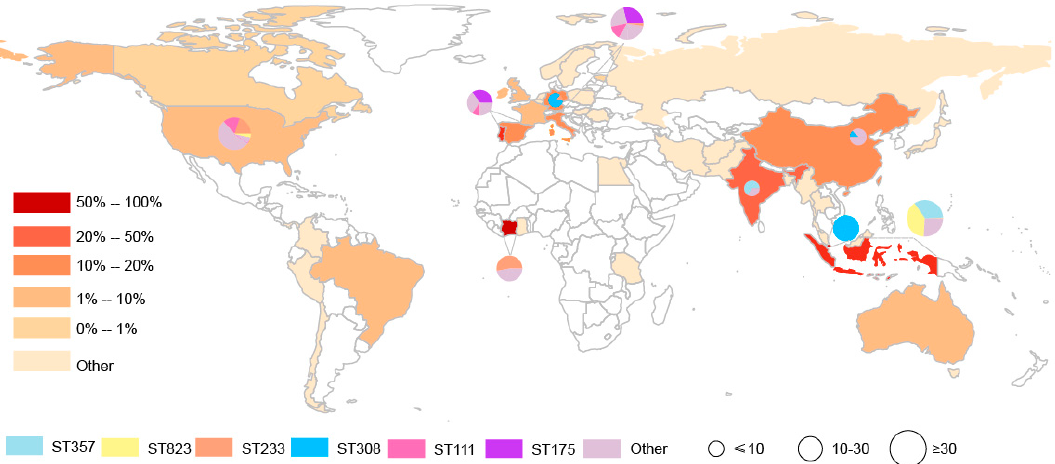
Figure 2. Geographic distribution and MLST diversity of carbapenemase-producing P. aeruginosa isolates. The presence of the carbapenemase-producing P. aeruginosa isolates is indicated by brown; the pie chart represents MLST diversity.